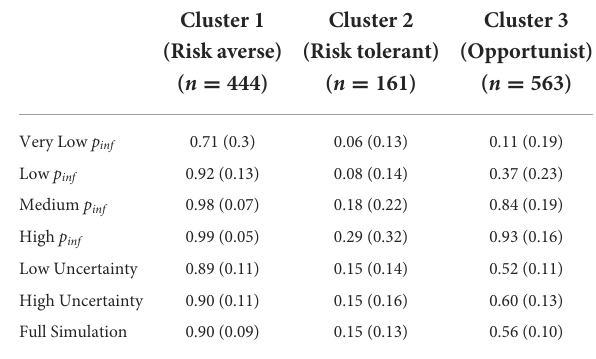
TABLE 1 Experimental game risk cluster compliance